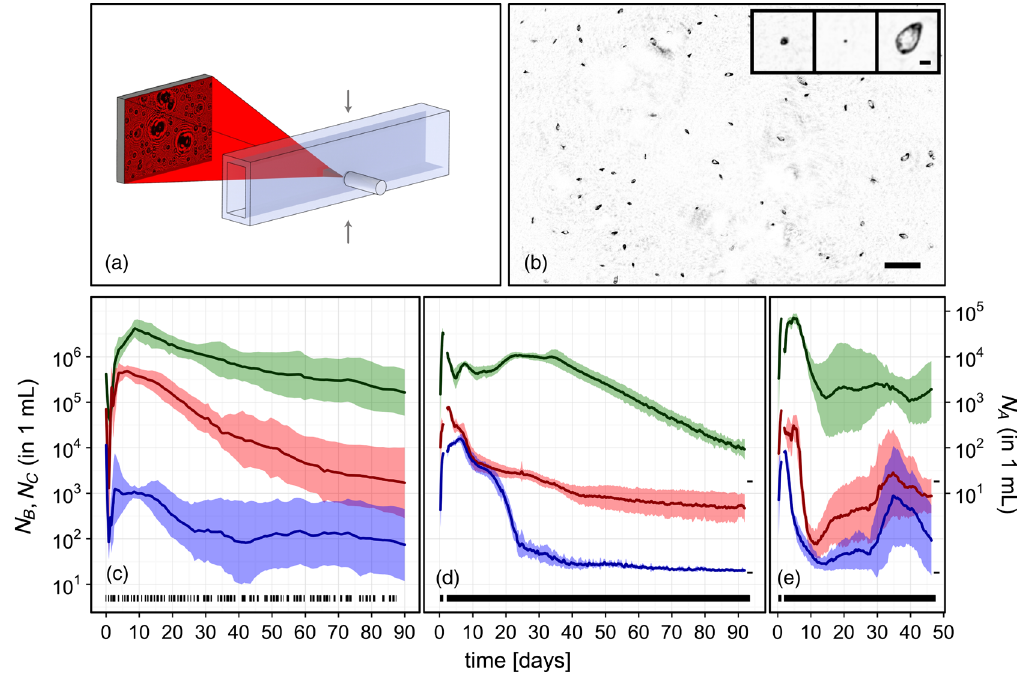
FIG. 1. Closed ecosystem population dynamics by digital holography. (a) Imaging schematic: A red laser beam diverges from a focus at the surface of a gradient-index (GRIN) lens (cylinder on lower right) and illuminates a region within the cuvette containing the microbial ecosystem, forming an interference pattern or hologram, which is recorded by a camera sensor (rectangle, left). Arrows above and below the cuvette indicate the direction of homogeneous white illumination provided by LEDs. (b) A single plane, near the wall of the cuvette facing the camera sensor, is reconstructed computationally from the hologram in (a). Hundreds of such planes form a 3D image of the observed volume. Gray scale represents intensity. The scale bar is 200 μ m. Many T. thermophila and some C. reinhardtii are visible. E. coli are not readily distinguished by eye in this image (see Appendix B). Inset: Magnified images of, from left to right, C. reinhardtii , E. coli , and T. thermophila at the same magnification and contrast. The scale bar is 10 μ m. (c) Population dynamics from previous work [13], measured by fluorescence microscopy, in 24 replicate ecosystems. The curve indicates the geometric mean abundance across replicates, and the shaded region includes 1 geometric standard deviation above and below the geometric mean. Vertical black dashes along the bottom indicate measurement times. Green ( A — algae, right axis): C. reinhardtii ; red ( B — bacteria): E. coli ; blue ( C — ciliates): T. thermophila . (d) Population dynamics measured by digital holography, in 10 replicate ecosystems with I ¼ I 0 (1200 lx) constant illumination. Species abundances were measured every 400 s. A gap occurred between 1.1 and 2.3 days, when abundances were too high to measure. The horizontal dashes on the right indicate the offset applied to zero counts to avoid divergence of log transforms. The individual time series used to calculate these statistics are shown in Fig. 2(b). (e) Geometric mean and standard deviation for 10 replicates in I ¼ 0 . 25 I 0 illumination [see individual time series in Fig. 2(a)]. Note that for (c – e) the vertical axis on the left of panel (c) applies to N and N for all three panels, while the vertical axis on the right of panel (e) applies to N in all three B C A